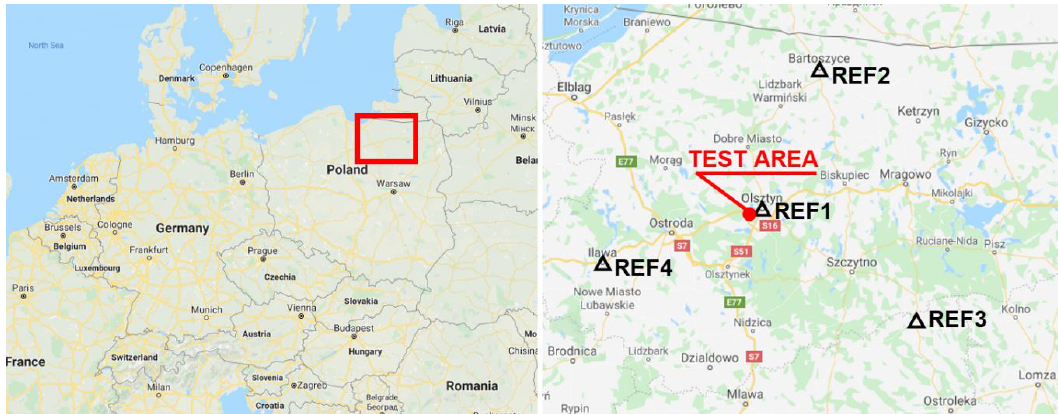
Figure 8. Location of the test area and CORS stations around the test area.